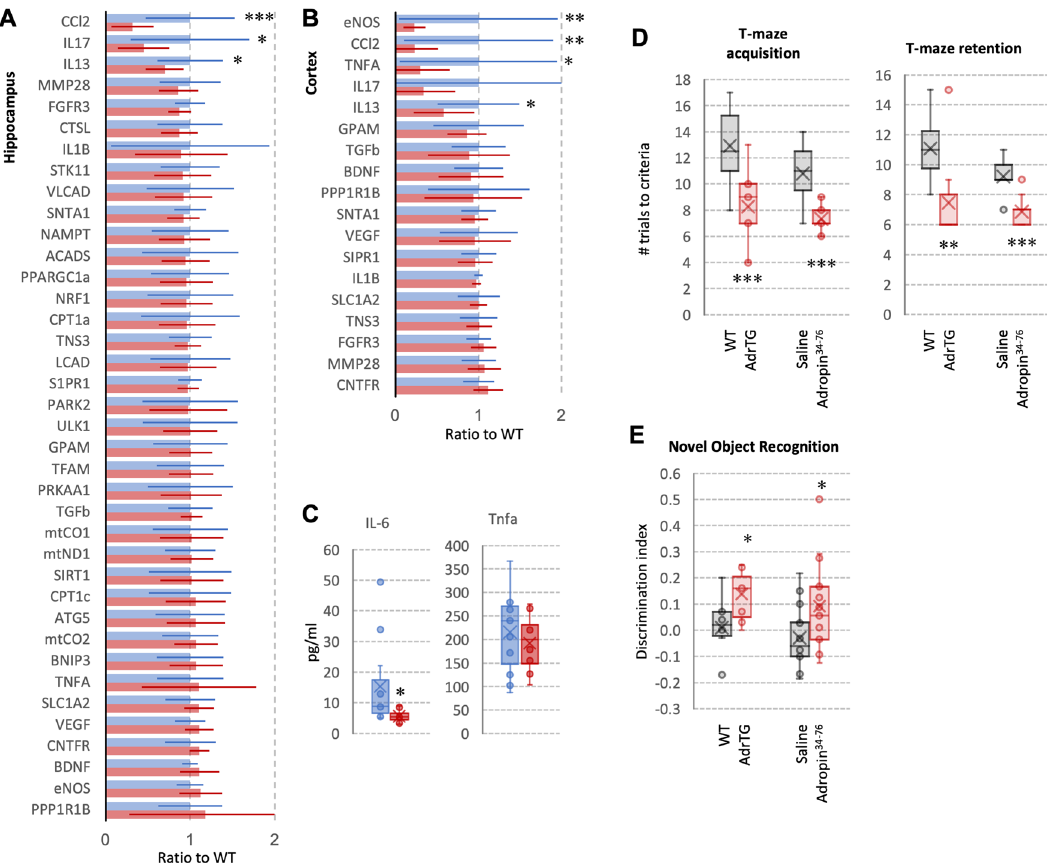
Fig. 8 Reduced expression of genes involved in in fl ammation and improved performance in tests of spatial learning and memory and novel object recognition in 18-month-old mice treated with adropin. A , B Reduced expression of genes involved in in fl ammation in the hippocampus ( A ) and cortex ( B ) of male 18-month-old AdrTG mice ( n = 13) compared to age-matched controls ( n = 12). Expression data (mean, SD) reported as a ratio of WT controls for each gene against 3 ‘ housekeeping ’ reference genes ( Hprt1, 36b4, Ppib ). C Serum levels of IL-6 but not TNFA are lower in AdrTG compared to controls. Signi fi cance is indicated by *( p < 0.05), **( p < 0.01), or ***( p < 0.001). D – E Improved performance in tests of spatial learning and memory (aversive T-maze) ( D ) or novel object recognition ( E ) of 18-month-old AdrTG ( n = 9) or B6 mice treated with adropin 34-76 for 2 weeks ( n = 14) compared to the respective age-matched control group (WT littermates for AdrTG, n = 10; mice treated with diluent for the adropin 34-76 treatment group; n = 15). Signi fi cance is indicated by *( p < 0.05), **( p < 0.01), or ***( p <